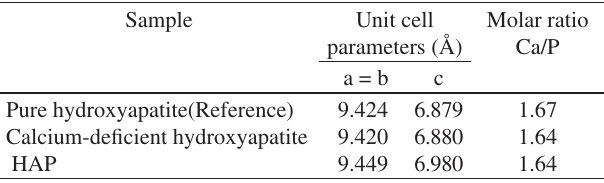
Table 1. Structural parameters and chemical analysis of HAP synthesized.